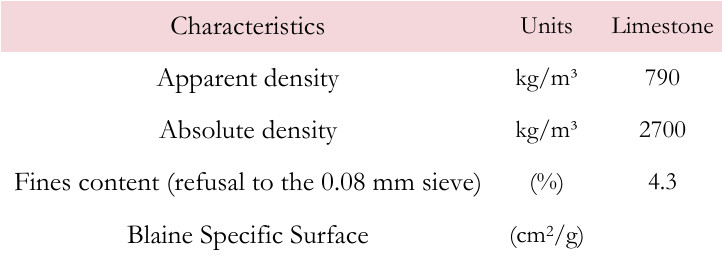
Table 5: Intrinsic characteristics of the limestone fillers used.